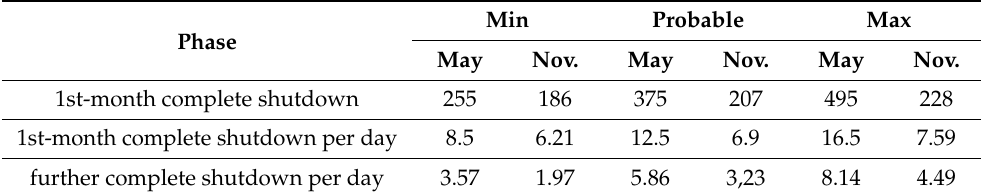
Table A5. Relative uncertainty ranges of costs in EUR bn.